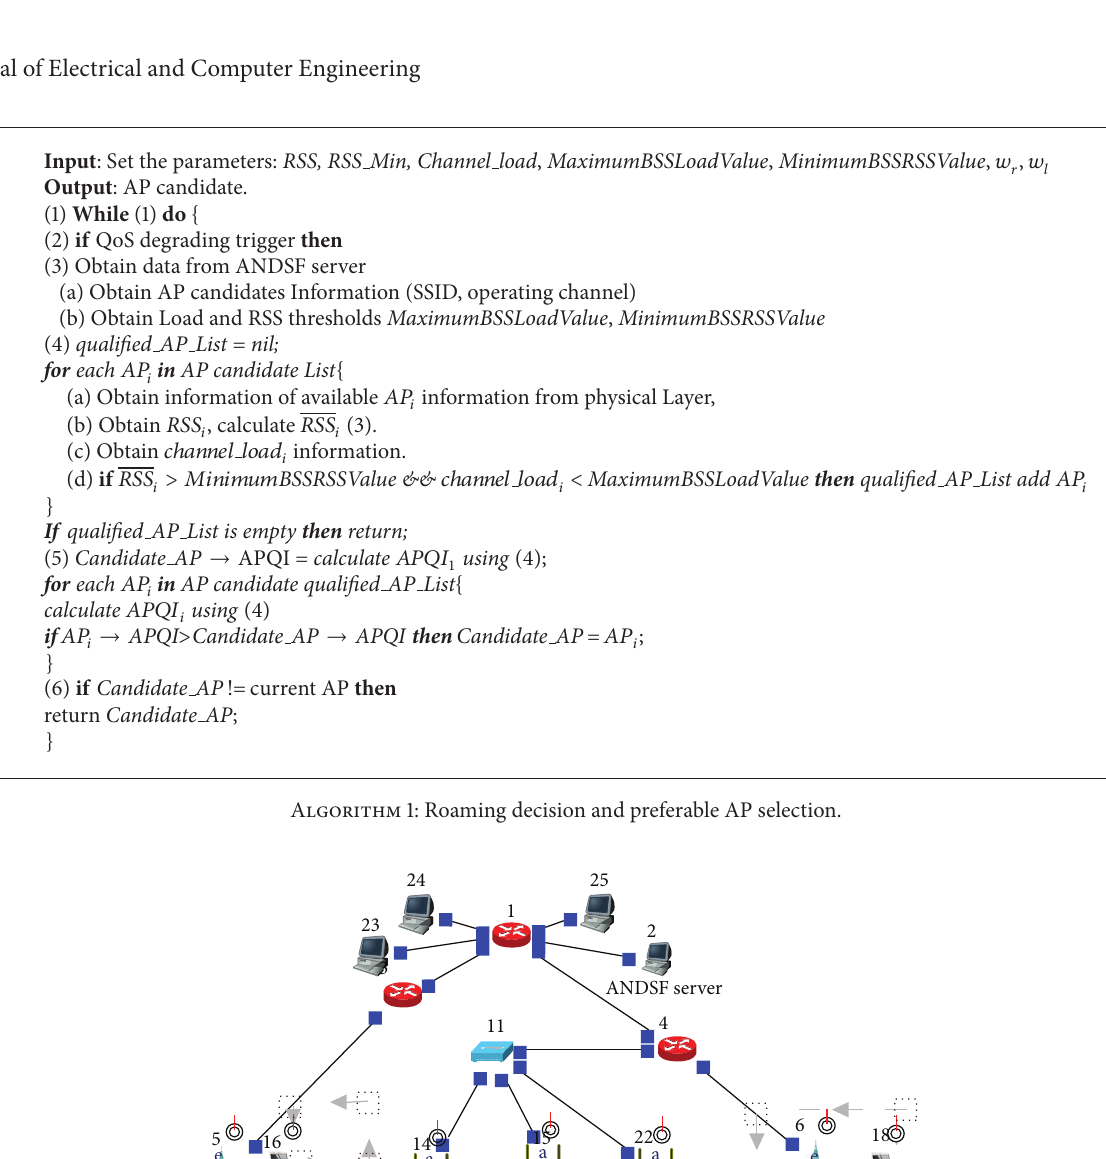
Figure 4: Simulation scenario setup for HetNet with interworking WiMAX BSs, WiFi APs, and Multiple Interfaces UEs.